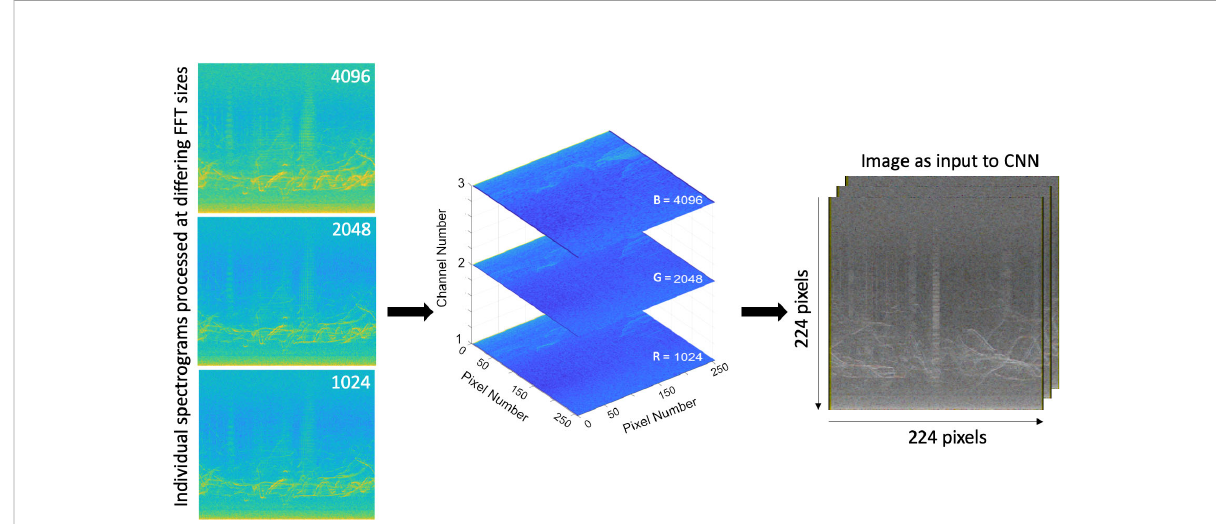
FIGURE 5 Graphic demonstrating the structure of the input to the model, a 3-channel greyscale spectrogram and is resized after processing to 224x224. Three spectrograms were produced for each wav fi le with different FFT size parameters as input: NFFT values were standardised for the equivalent of 1024, 2048 and 4096 points per each sample rate with a constant frequency increment of 93.75 Hz, 46.88 Hz and 23.44 Hz respectively. Spectrograms were computed using a Hanning window and 75% overlap. The three images were stacked within one of three color channels of the image in order, allowing the CNN to ‘ see ’ each sound source represented at various